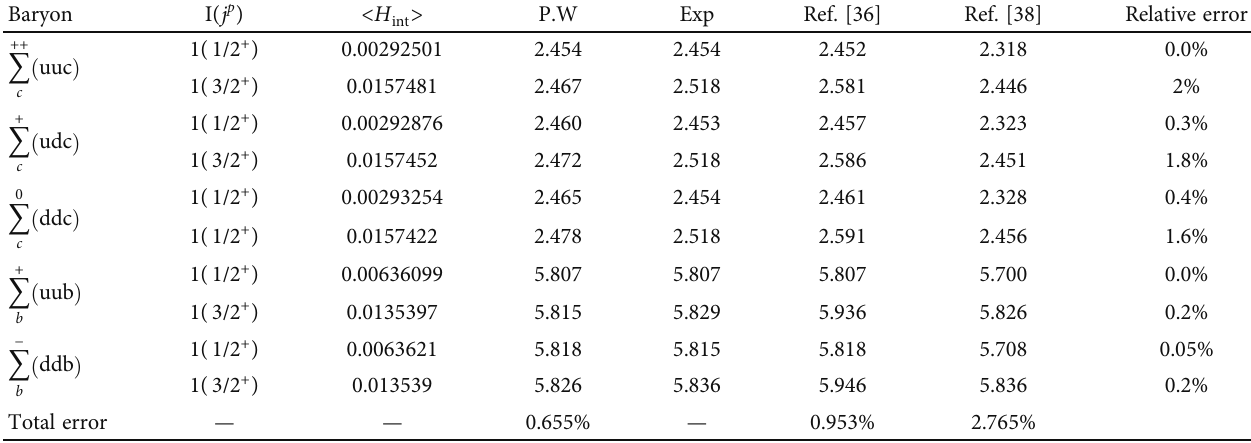
Table 7: Single charm and beauty baryon masses in ground state (masses are in GeV) at ( α = β = 0 : 678 ) and ( α = β = 0 : 54 ). The last column shows the relative error in comparison to experimental data.